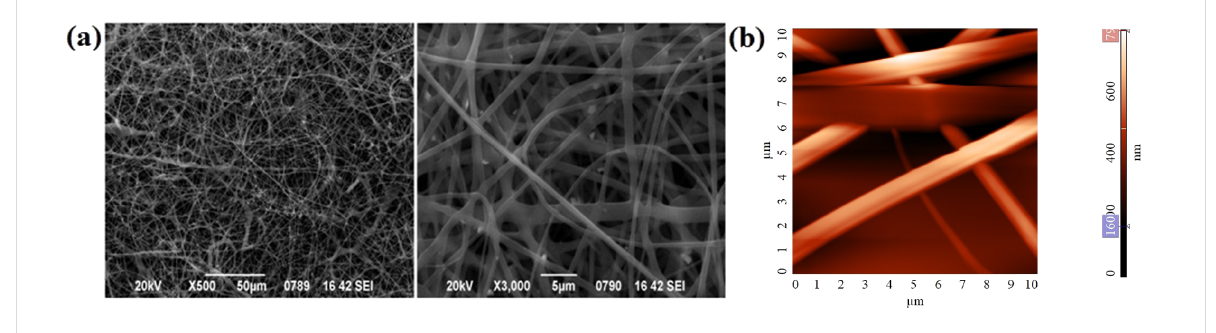
Figure 1: (a) Representative SEM micrographs of electrospun CA fibers, (b) AFM topography image of CA scaffolds with root mean square S q = 135 nm and peak-to- peak S y = 795